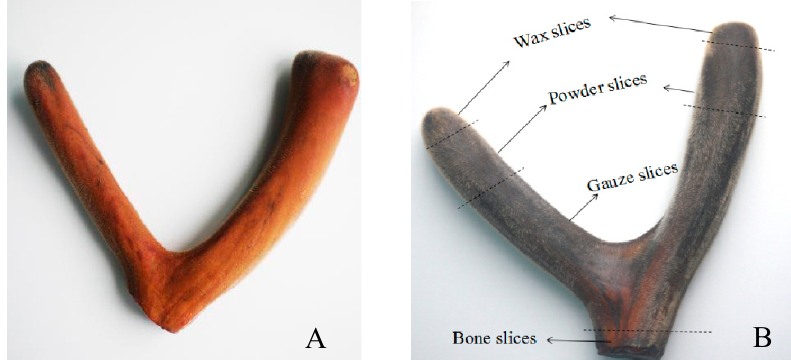
Figure 2. Schematic diagram of fresh antler velvet ( A ) and different sections of processed antler velvet ( B ). The processed antler velvet has a significant Maillard reaction browning compared to the fresh antler velvet. The processed antler velvet was divided into wax slices, powder slices, gauze slices, and bone slices based on morphological and microscopic